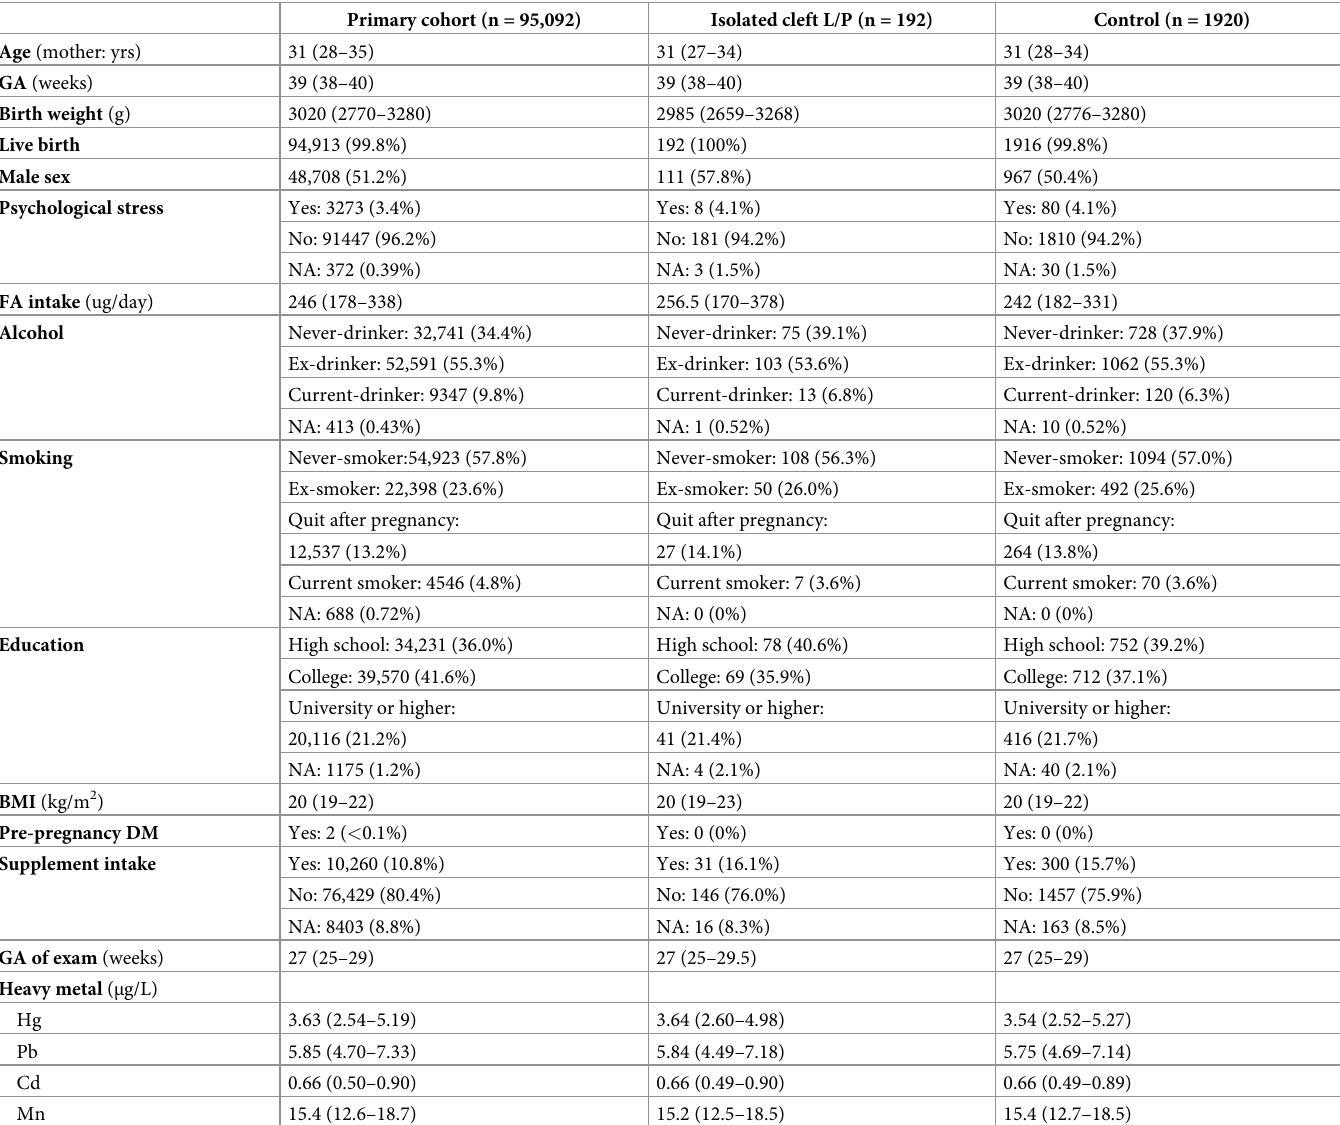
Table 1. Characteristics of the primary cohort and matched pairs 1 .